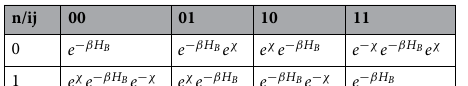
ω k b † b k k k (cid:31)